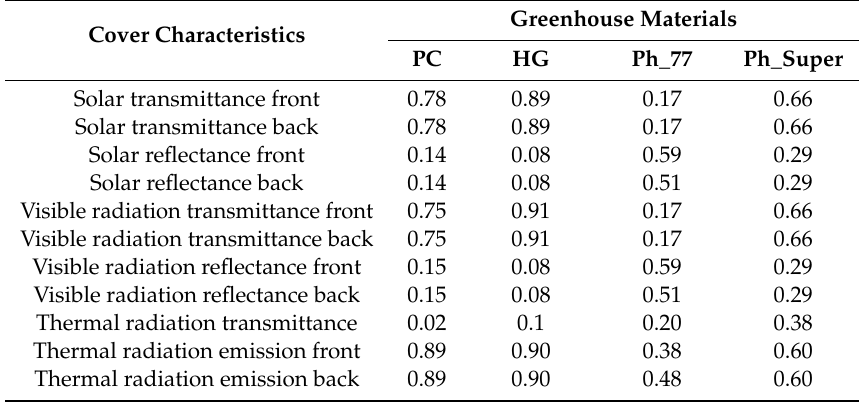
Table 2. Physical and thermal properties of the greenhouse coverings and thermal